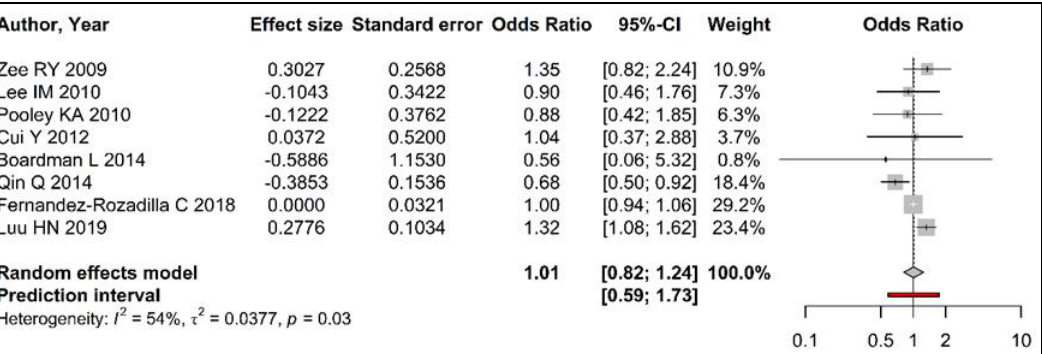
Figure 2. Forest plot summarizing the association between telomere length (comparing longest quartile vs. shortest) in peripheral blood leukocytes and risk of colorectal cancer using random effects model.